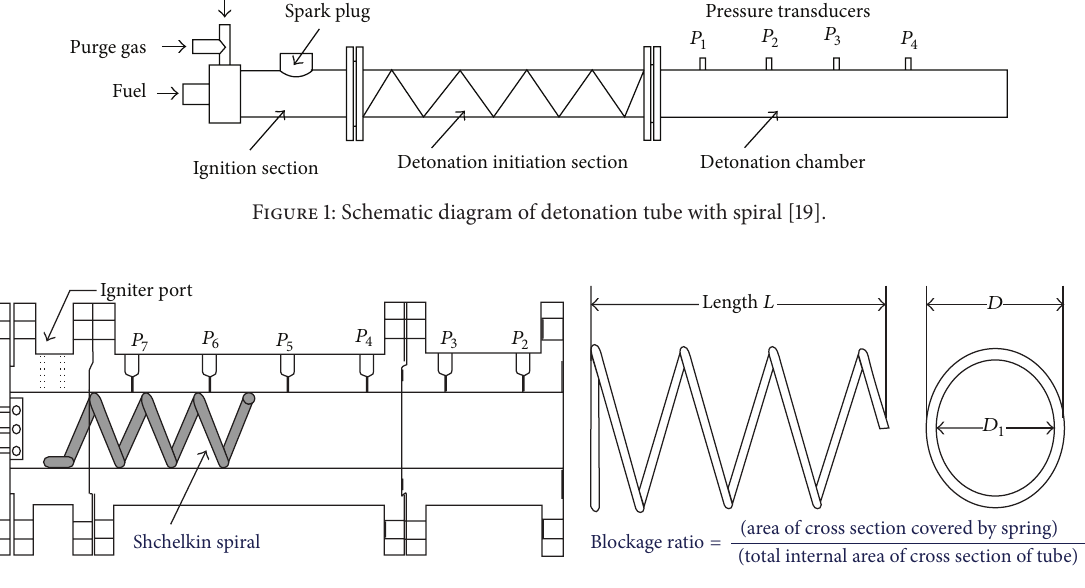
Figure 2: Schematic view of Shchelkin spiral configuration [21].